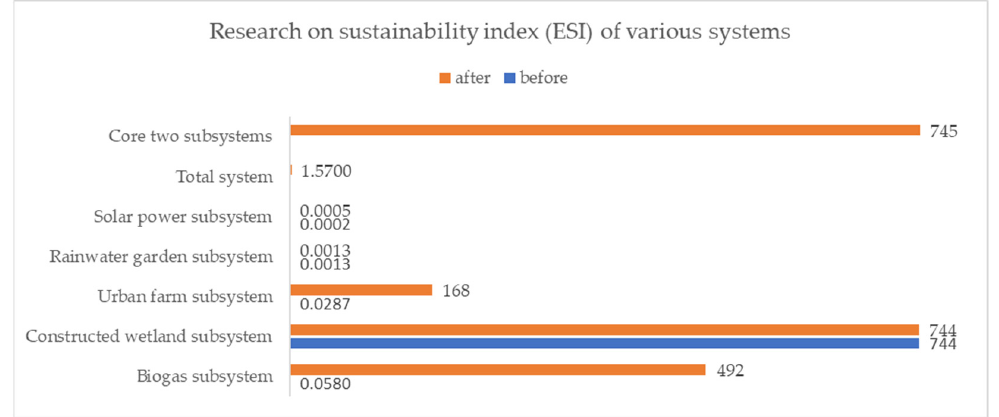
Figure 11. Research on sustainability index (ESI) of various systems.